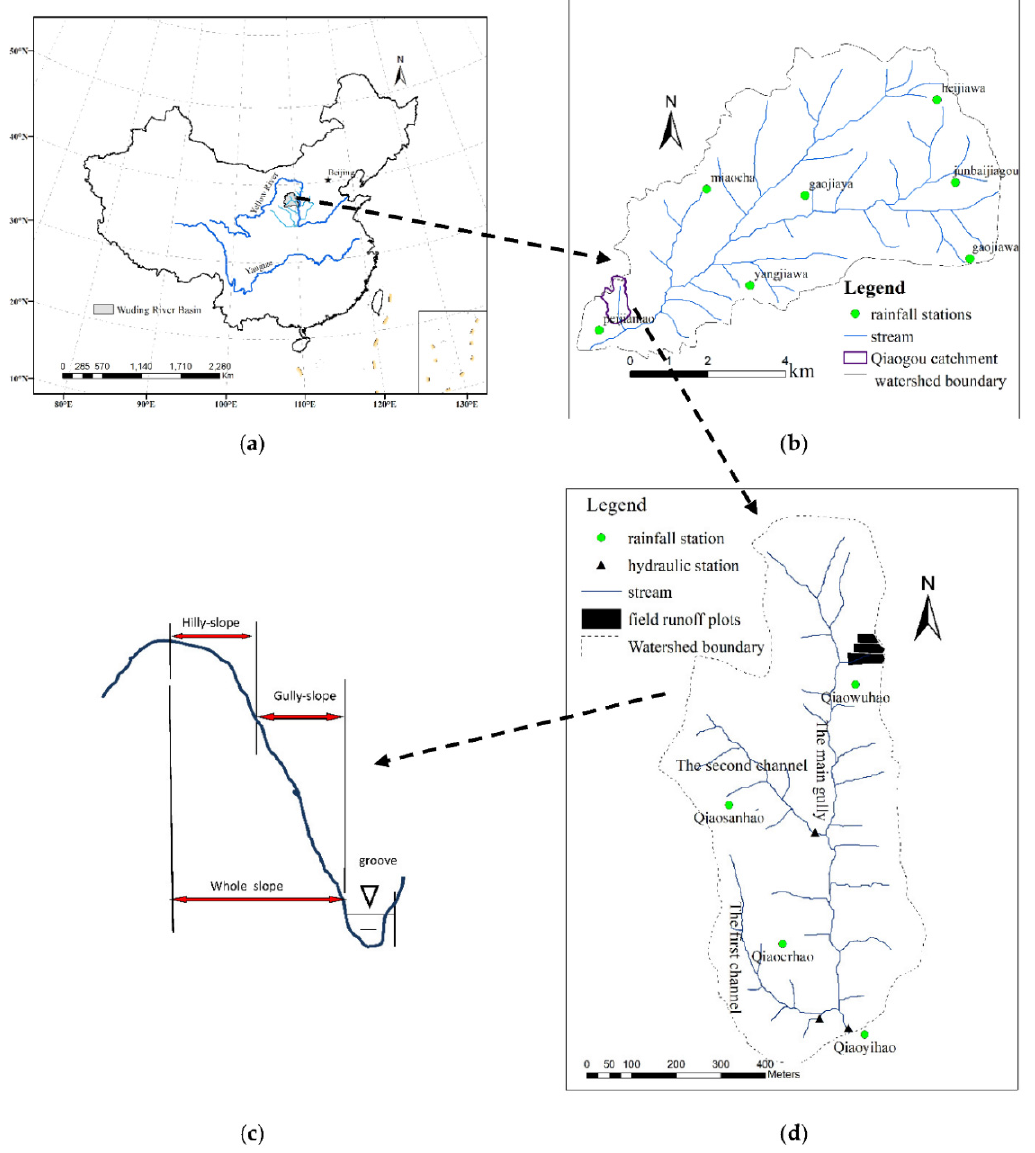
Figure 1. Location of the study area and the instrumentation in the watershed. ( a ) Reaches of the Yellow River. ( b ) Peijiamao watershed. ( c ) Profile of the runoff plot. ( d ) Qiaogou